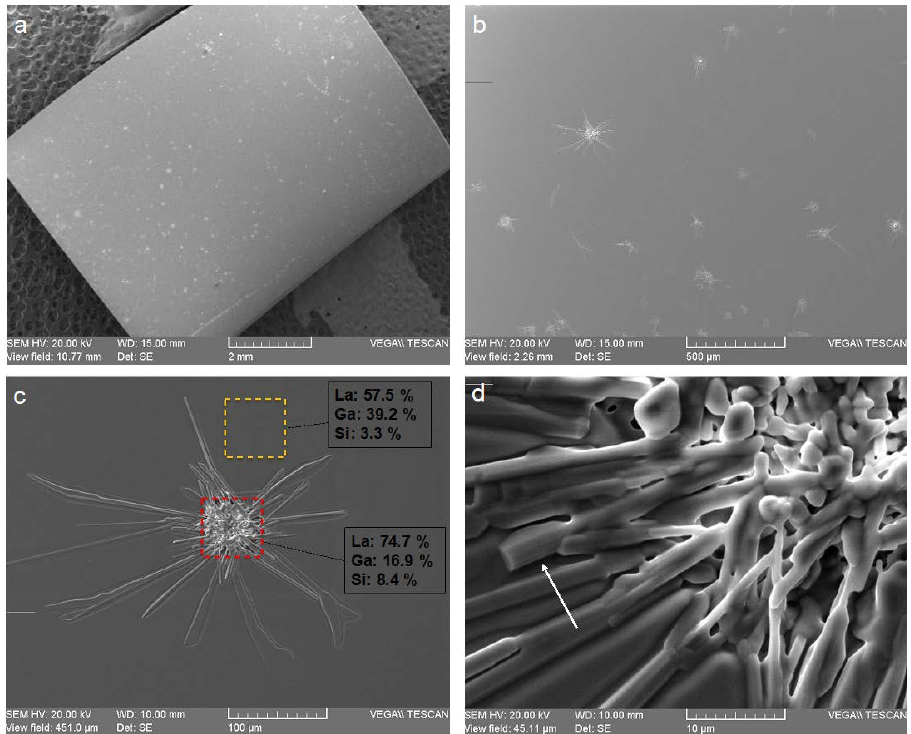
Figure 3. SEM images of the LGS surface after a one-week annealing period at 1200 ◦ C in an air atmosphere. ( a ) Overall image of the substrate: the surface appears sprinkled with isolated defects. ( b ) A closer view of some defects. ( c ) A typical defect. Red and orange squares symbolize the EDXS measurement areas. ( d ) A close-up view of the center of the latter defect. The white arrow indicates a stick with crystalline